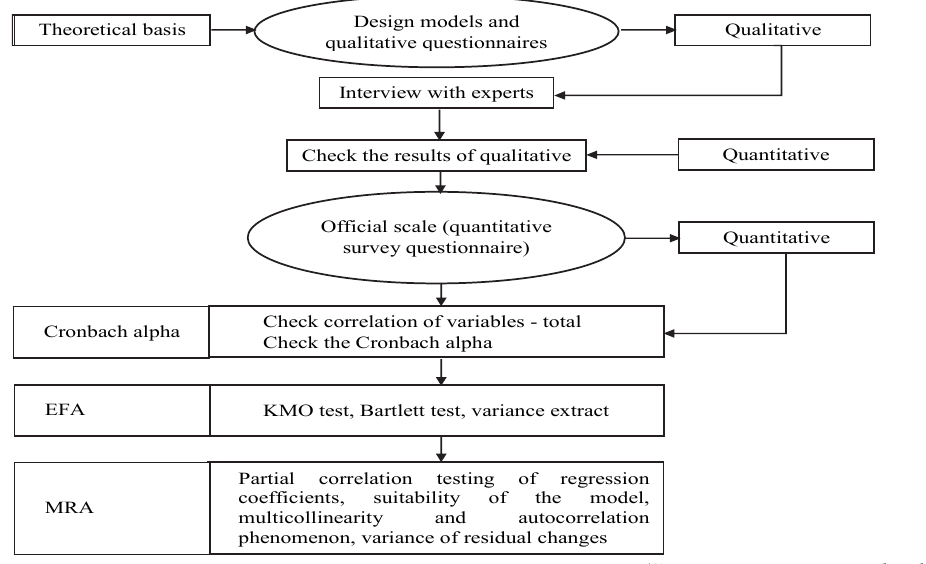
Fig. 2. Detailed research